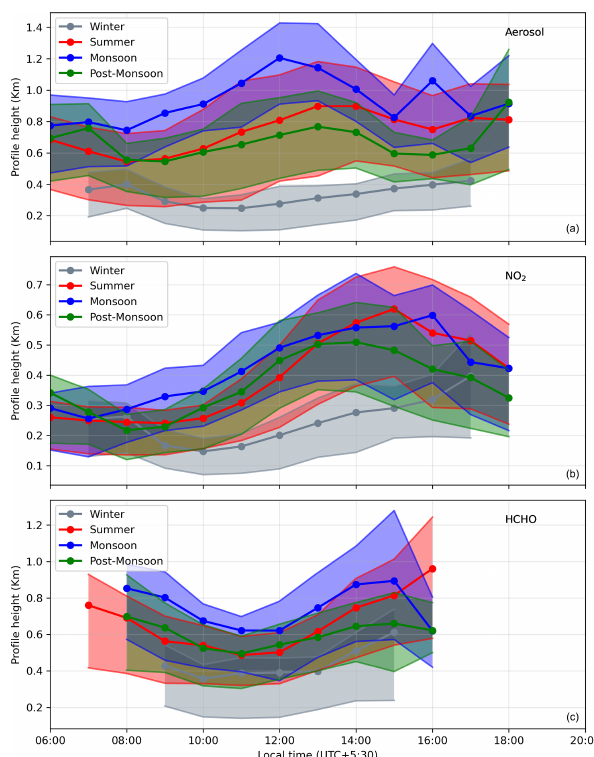
Figure F10. Diurnal variation in characteristic profile heights of aerosol (a) , NO 2 (b) , and HCHO (c) for the four major seasons.